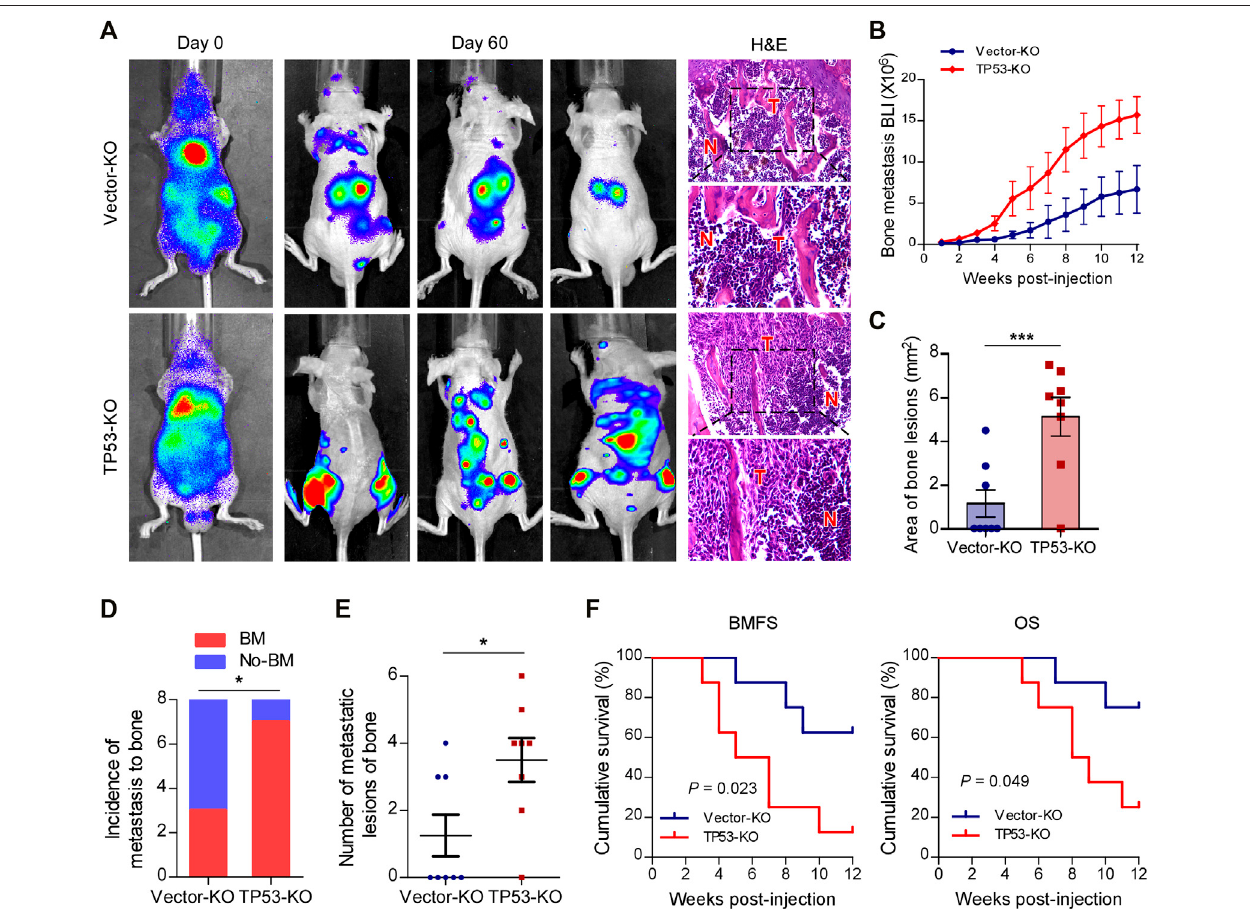
FIGURE 1 | Depletion of wt-p53 promotes bone metastasis and shortens survival in mice. (A) Representative BLI and histological images (H&E) of bone lesions from mice inoculated with C4-2B/ TP53 -KO or C4-2B/Vector-KO cells ( n (cid:1) 8/group). Red arrows indicate bone lesions by tumor (T). N, adjacent non-tumor tissues. (B) Growth curve for bone metastasis burden as quanti fi ed by BLI in the indicated groups of C4-2B cells. (C) Histomorphometric quanti fi cation of tumor area in hind limbs from each experimental group. (D) Frequency ofbone metastasis detected in each group ( χ 2 test). (E) Numbers of metastaticlesions in bones from each mouse in two groups. (F) Kaplan-Meier curves of bone metastasis-free survival (BMFS) and overall survival (OS) in mice from each experimental group (log-rank test). Error bars represent the means ± SEM. * p < 0.05, *** p < 0.001. P values were based on t -test unless otherwise indicated.